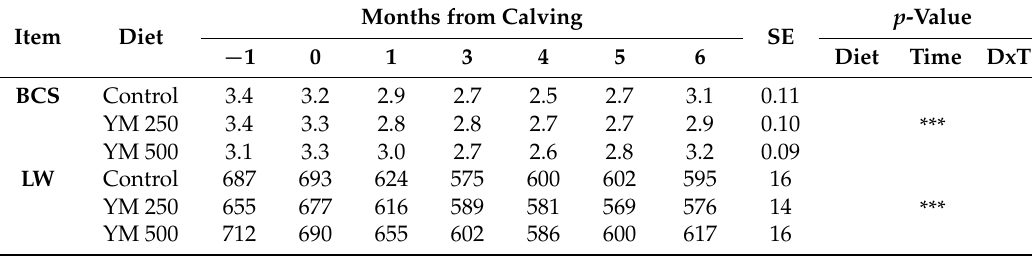
Table 2. Body condition score (BCS) and liveweight (LW) in dairy cows supplemented with Yerba Mate.